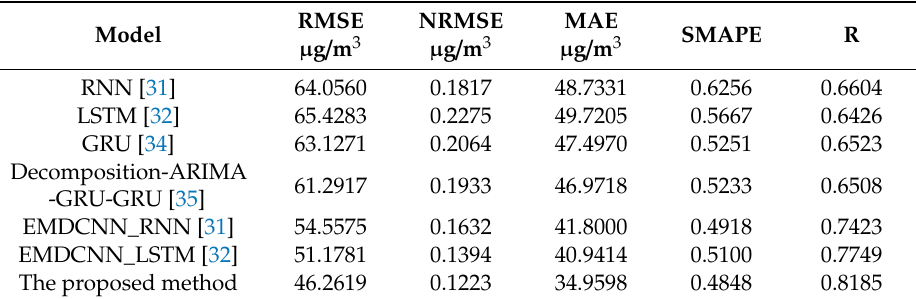
Table 1. Comparison of prediction results with di ff erent